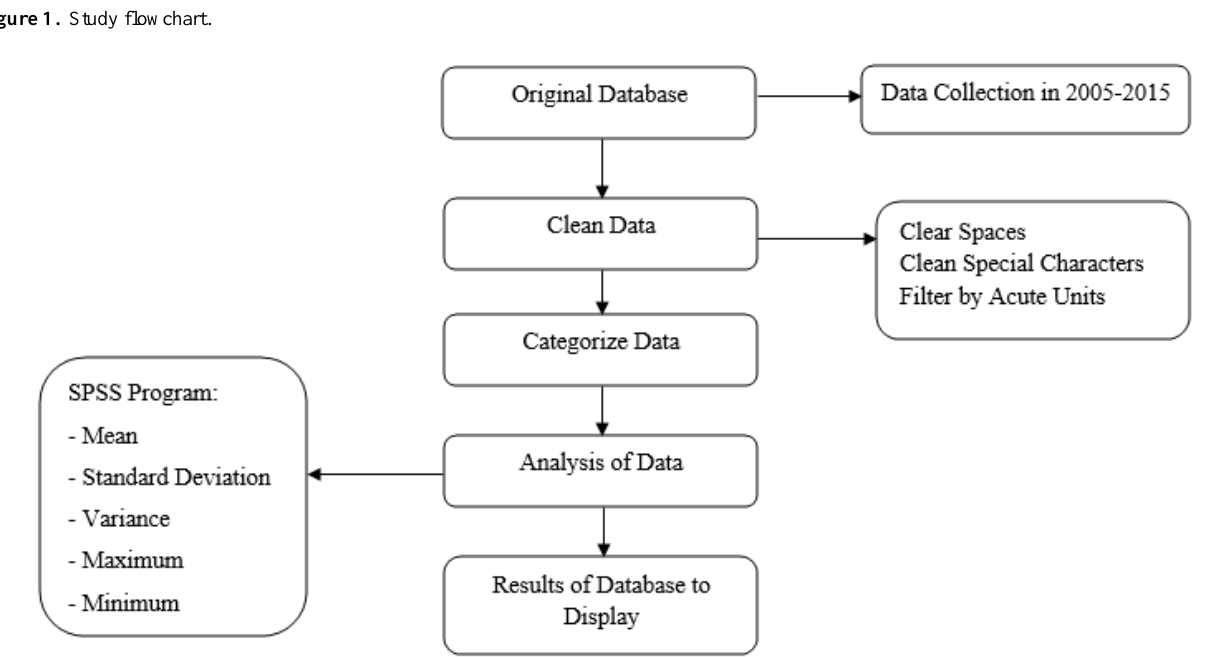
Figure 1. Study flowchart.